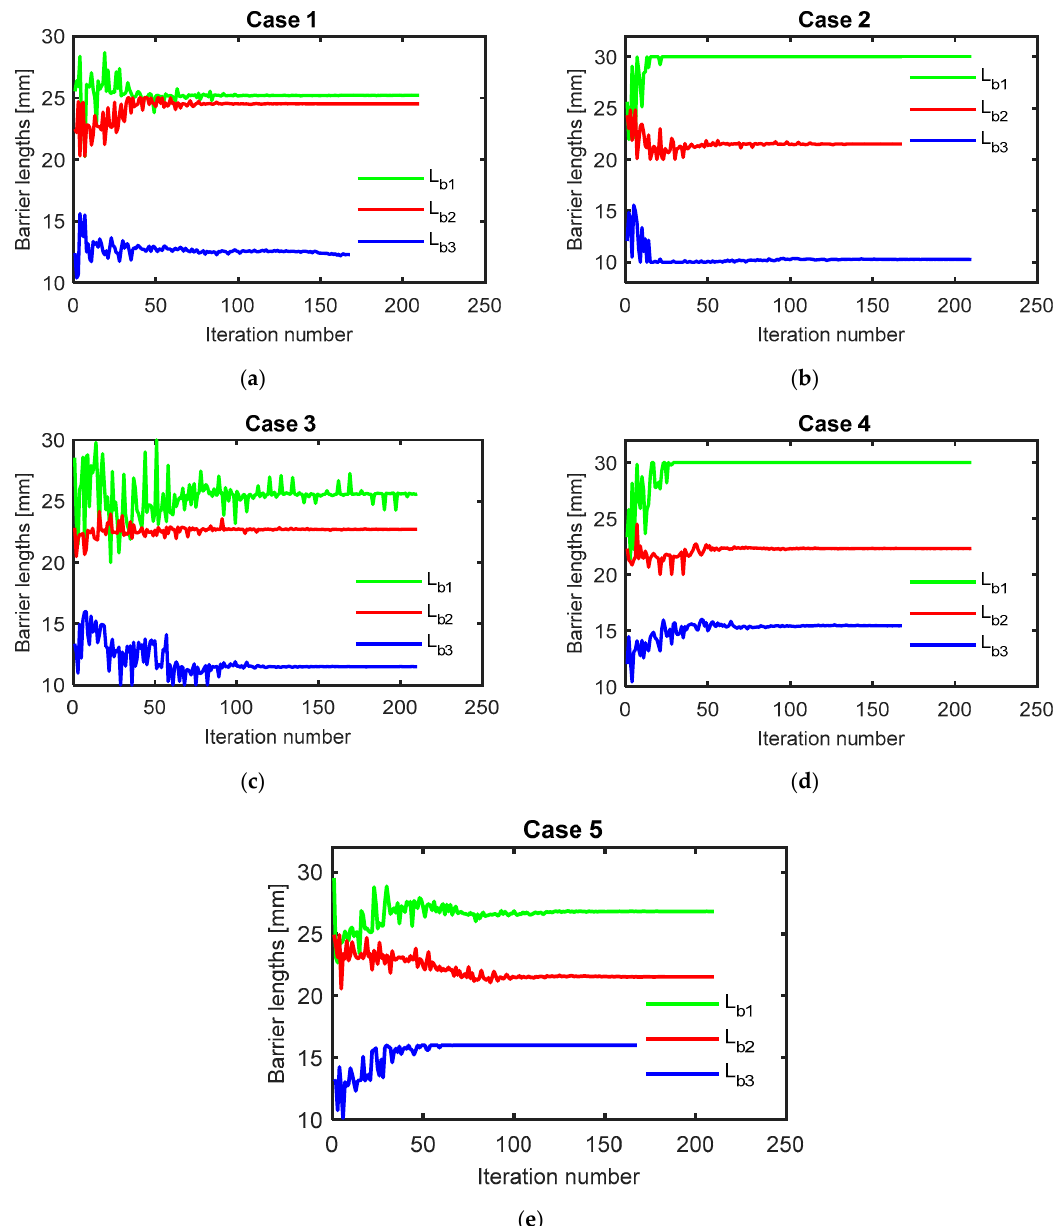
Figure 9. Optimal geometry of flux barrier lengths for different cases, ( a ) case 1, ( b ) case 2, ( c ) case 3, ( d ) case 4 and case 5.